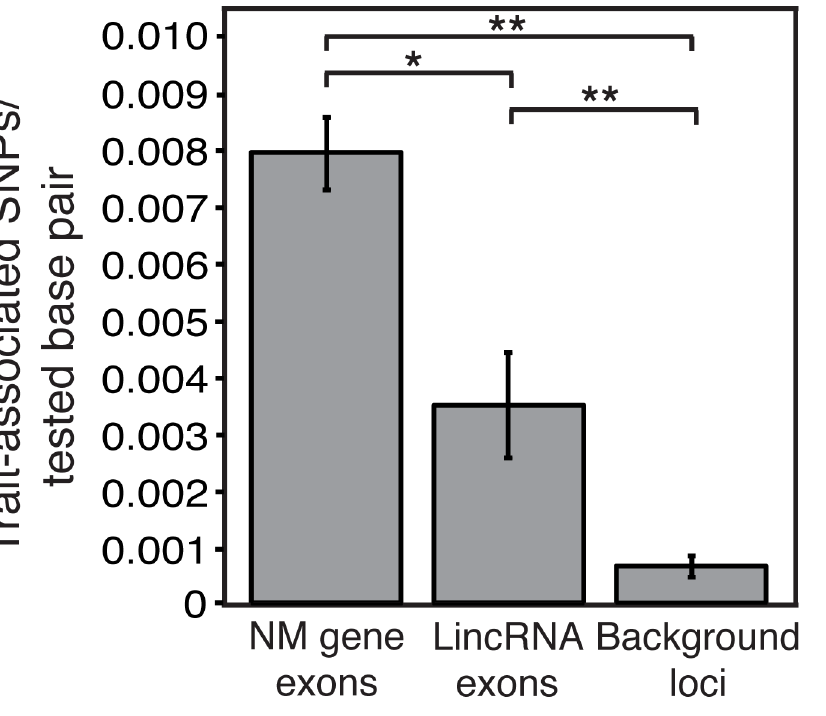
Figure 4. LincRNAs are enriched for trait-associated SNPs. The number of trait-associated SNPs within RefSeq NM gene exons, lincRNA exons, or background loci (nonexpressed intergenic sequence) per tested SNP in genome wide association studies is compared (see Methods). * P =0.0173, ** P , 2.2E-16; error bars represent 95% binomial proportion confidence interval.